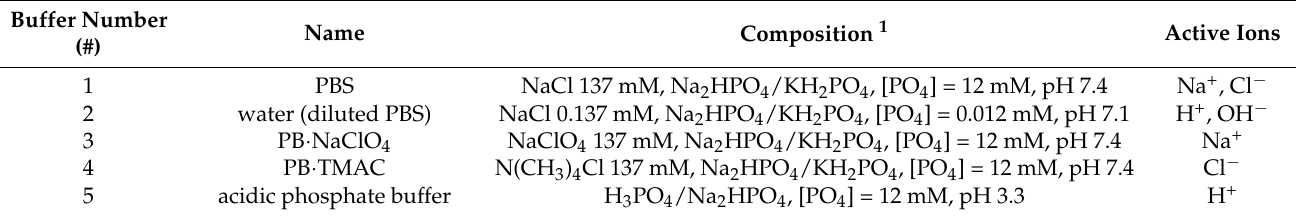
Table 2. Chemical composition and active ions of tested